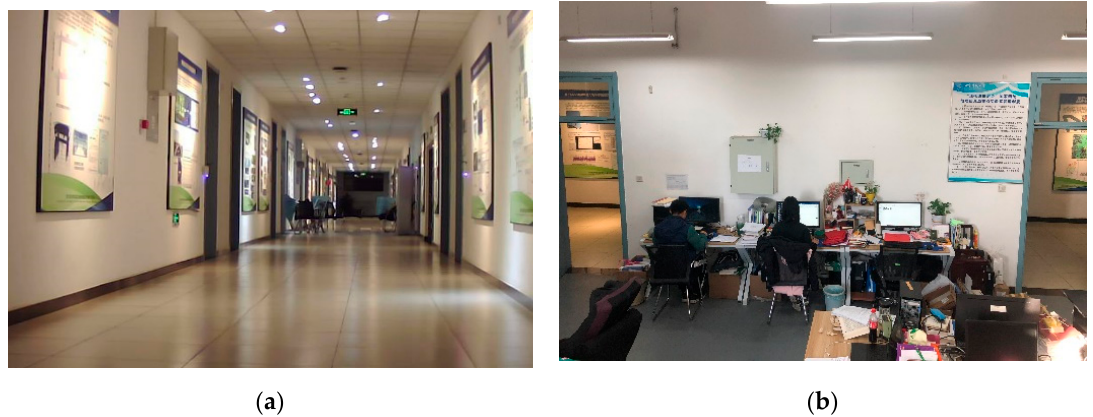
Figure 12. The scene of experiment 2. ( a ) Corridor; ( b ) laboratory room.